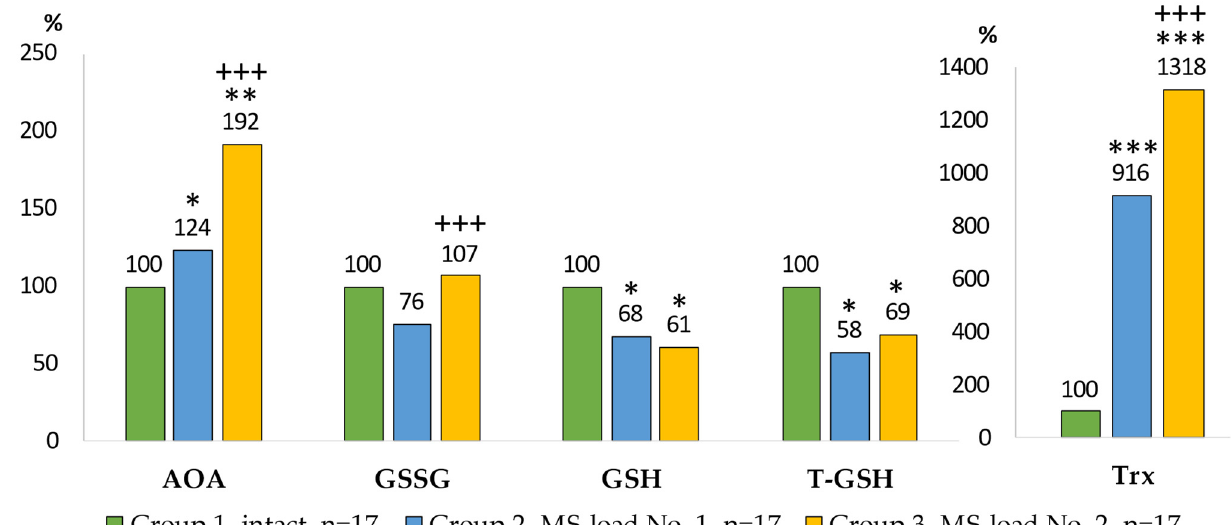
Figure 5. Indicators of the antioxidant system in the AM culture medium. Notes: statistical significance relative to Group 1: *— p < 0.05; **— p < 0.01; ***— p < 0.001; relative to Group 2: +++— p < 0.001.